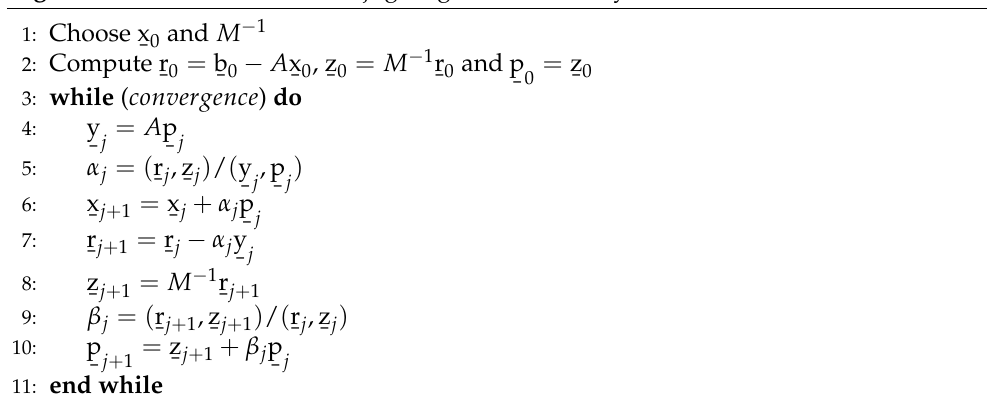
Algorithm 1 Preconditioned conjugate